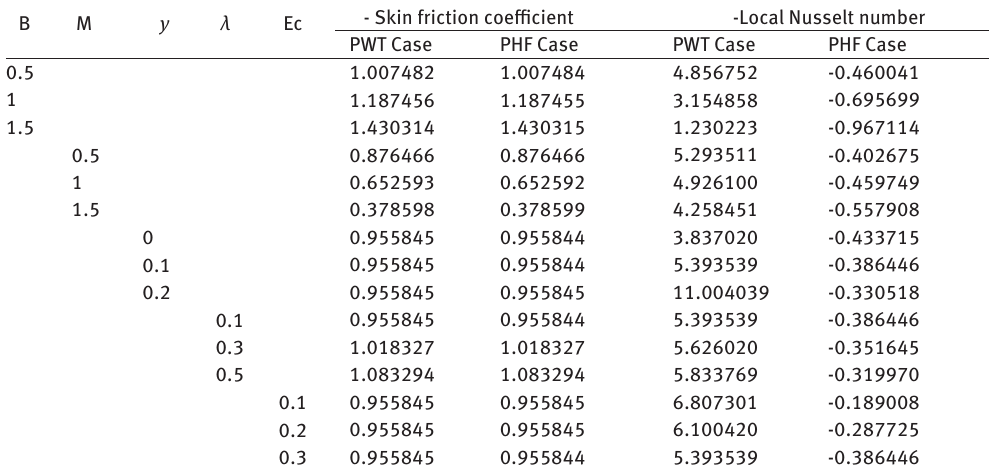
Table 2: Variations in Skin friction coefficient, local Nusselt number in Prescribed Wall temperature (PWT) case B M γ λ Ec - Skin friction coefficient -Local Nusselt